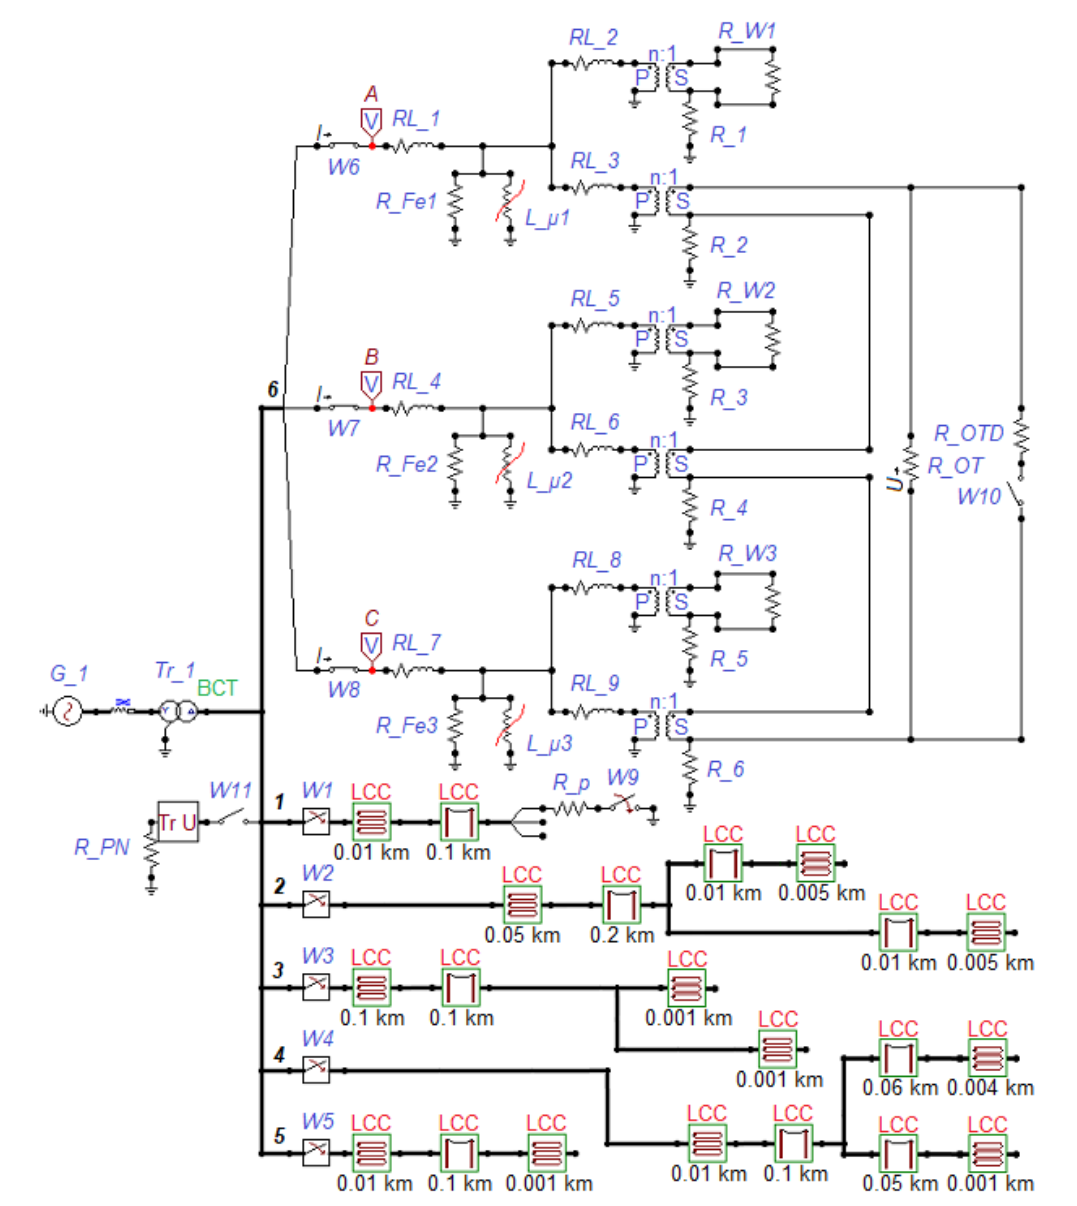
Figure 1. Model of the power network analyzed in the EMTP/ATP program, in which the ferroreso- nance phenomenon occurs.